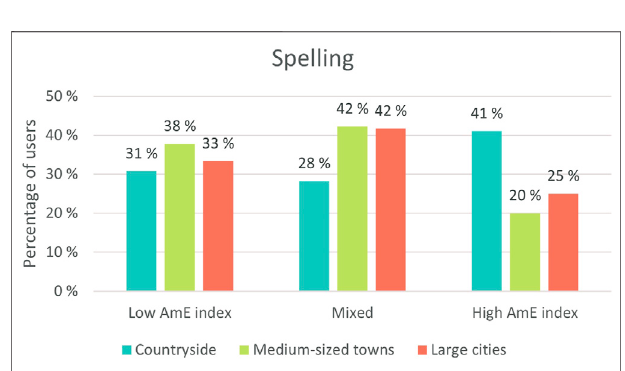
FIGURE 10 | Spelling variation in idiolects divided based on geographical location.